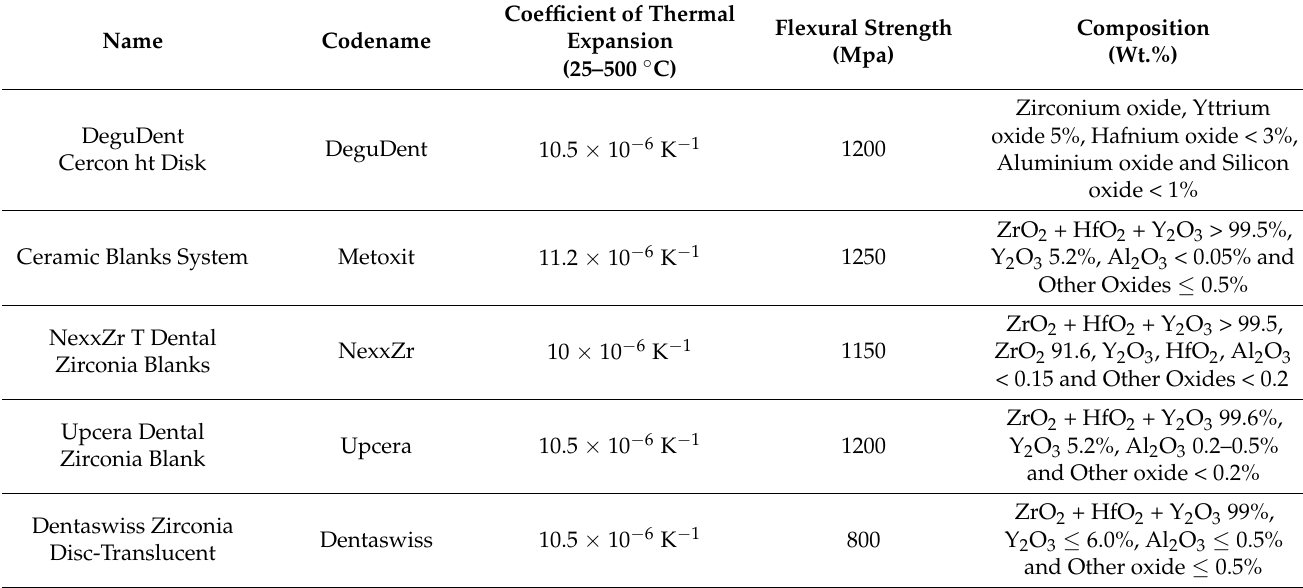
Table 1. Materials, Codename, Characteristic, and Composition of all tested materials.